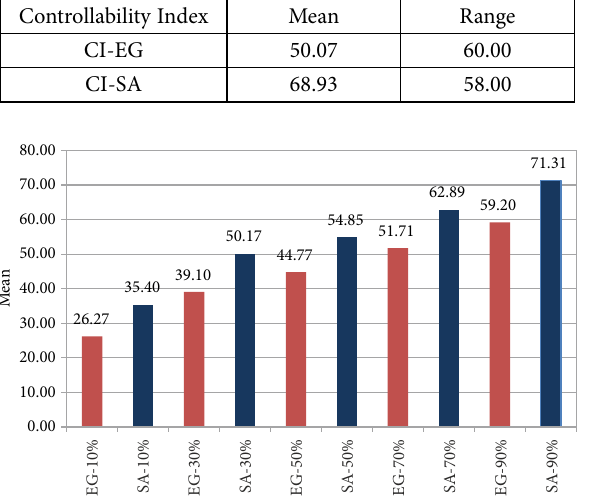
Figure 3. The mean of lean effect at various implementation levels